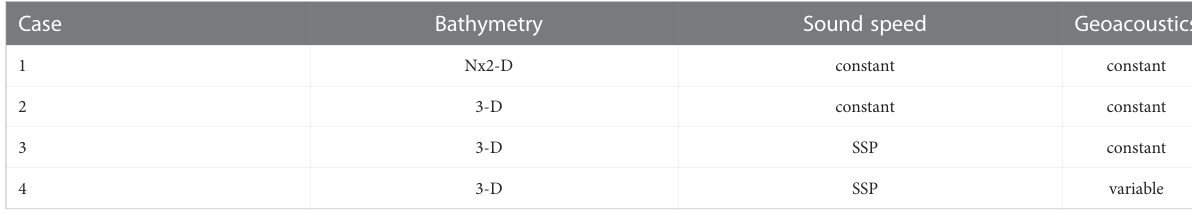
TABLE 1 Test cases and corresponding environmental input